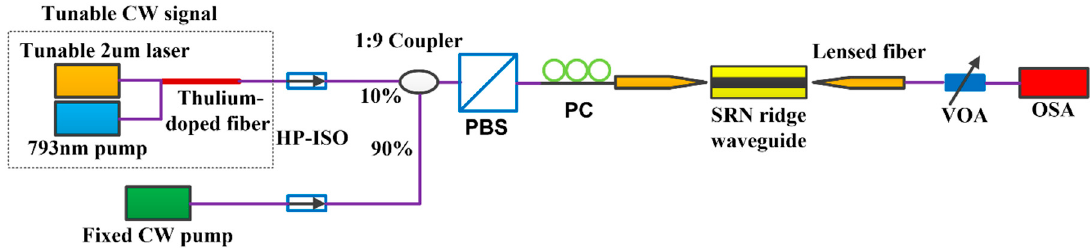
Figure 4. The experimental setup for four-wave mixing (FWM) experiments in the fabricated silicon-rich nitride (SRN) ridge waveguides. CW: continuous-wave; HP-ISO: high power isolator; PBS: polarization beam splitter; PC: polarization controller; VOA: variable optical attenuator; OSA: optical spectrum analyzer.